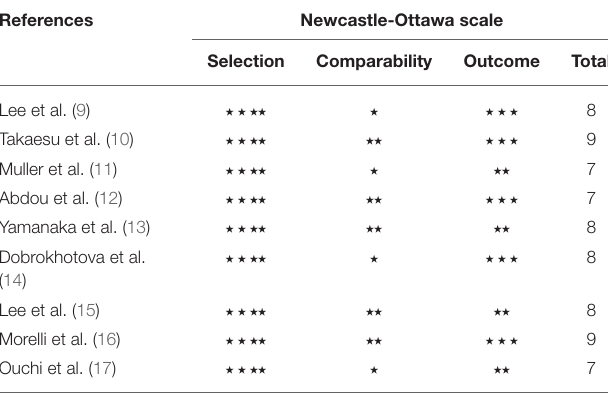
TABLE 2 | Assessment of bias risk of cohort